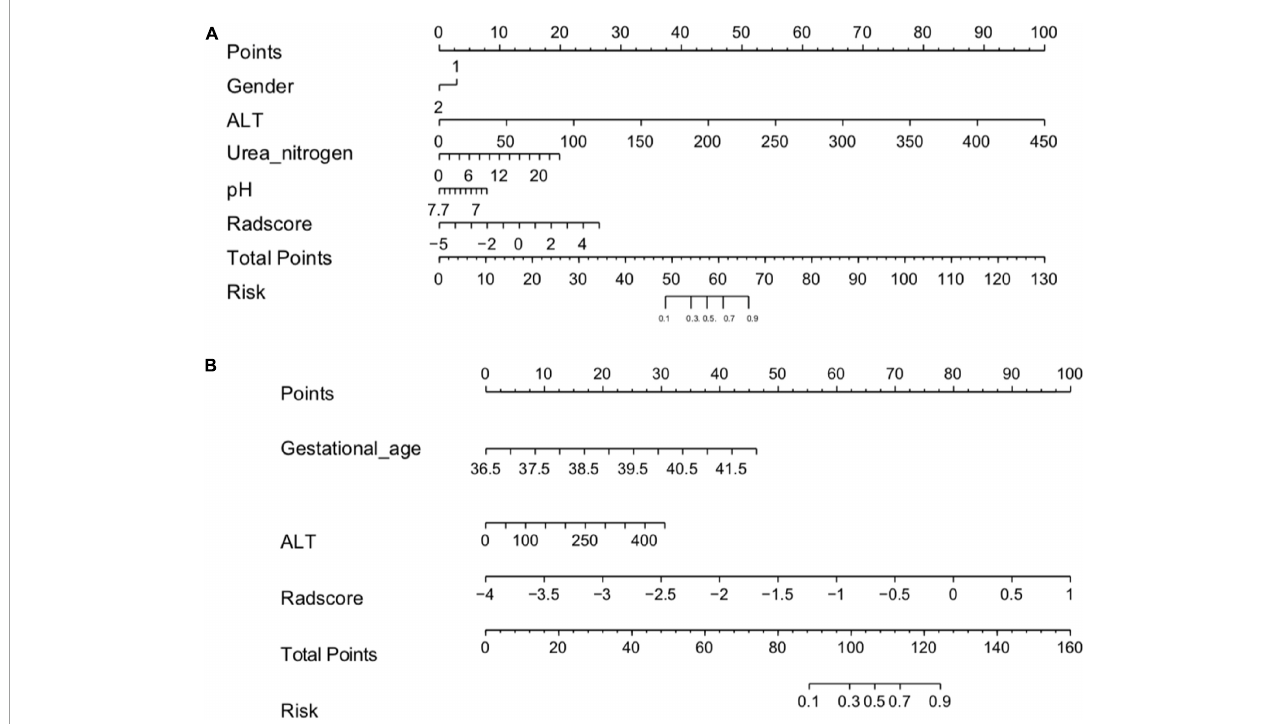
FIGURE2 (A) Radiomics nomogram (HIE vs. normal). In the training cohort, the nomogram incorporated the Rad-score and gender, ALT, Urea nitrogen, pH. (B) A radiomics nomogram (good outcome vs. poor outcome). In the training cohort, the nomogram incorporated the gestational age, Rad-score and ALT.